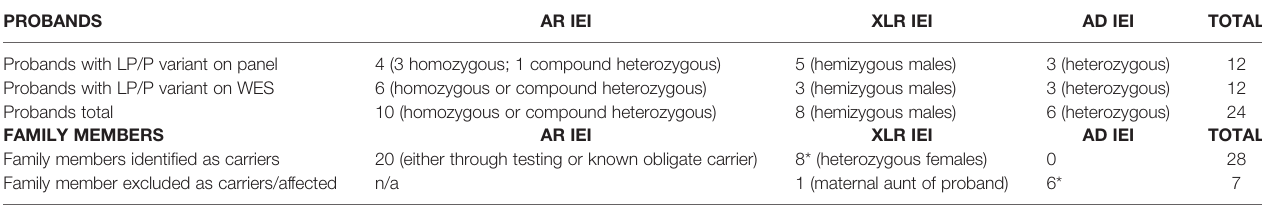
TABLE 3 | Summary of results from probands and family member